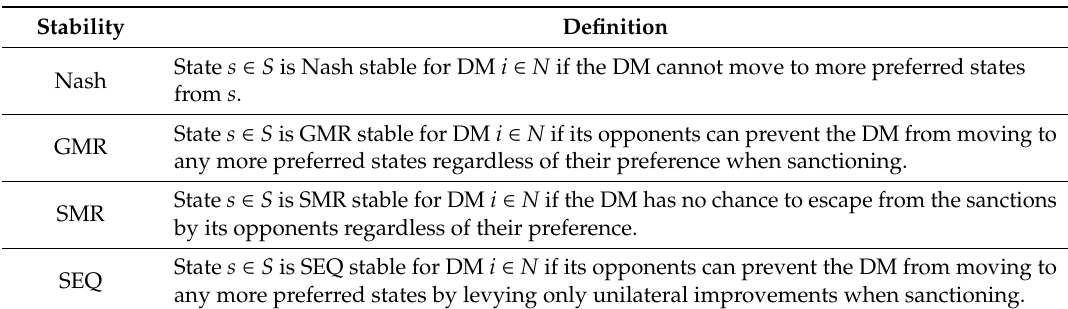
Table 7. Four kinds of stabilities in the graph model for conflict resolution (GMCR). GMR—general metarationality; SMR—symmetric metarationality; SEQ—sequential